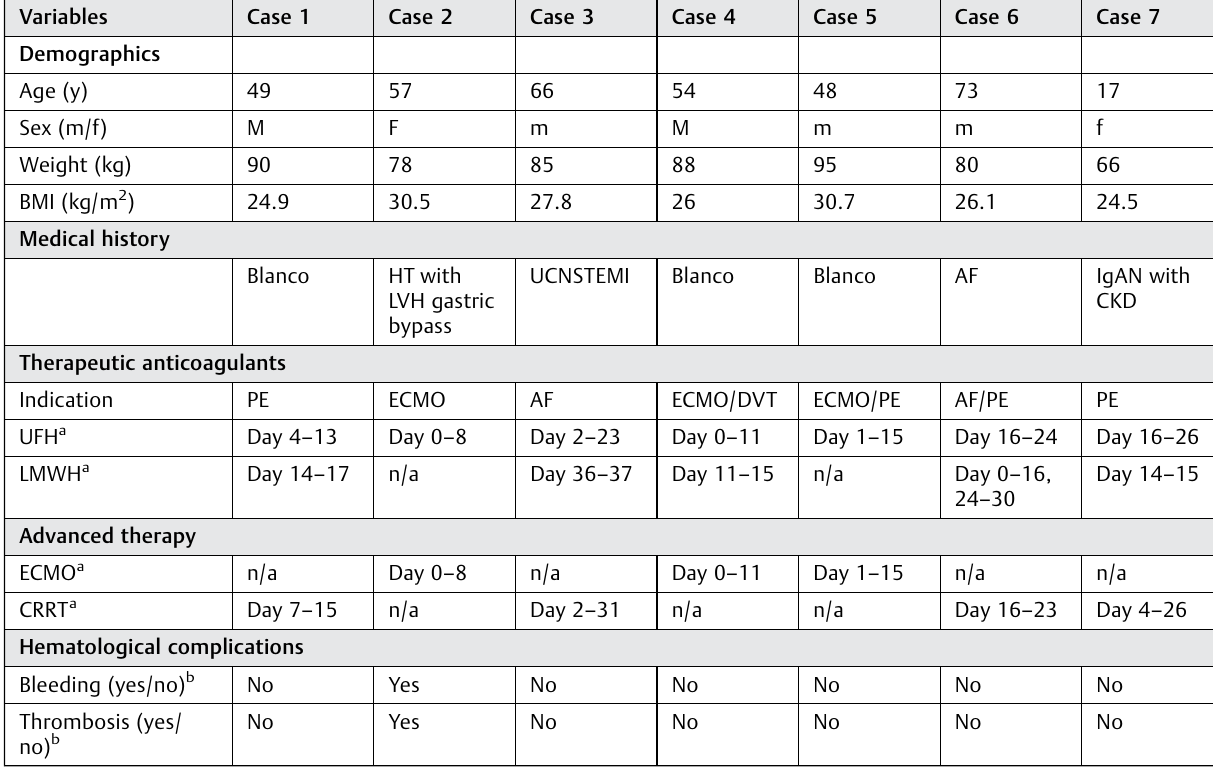
Table 2 Individual case description: individual cases are part of the Maastricht Intensive Care COVID cohort